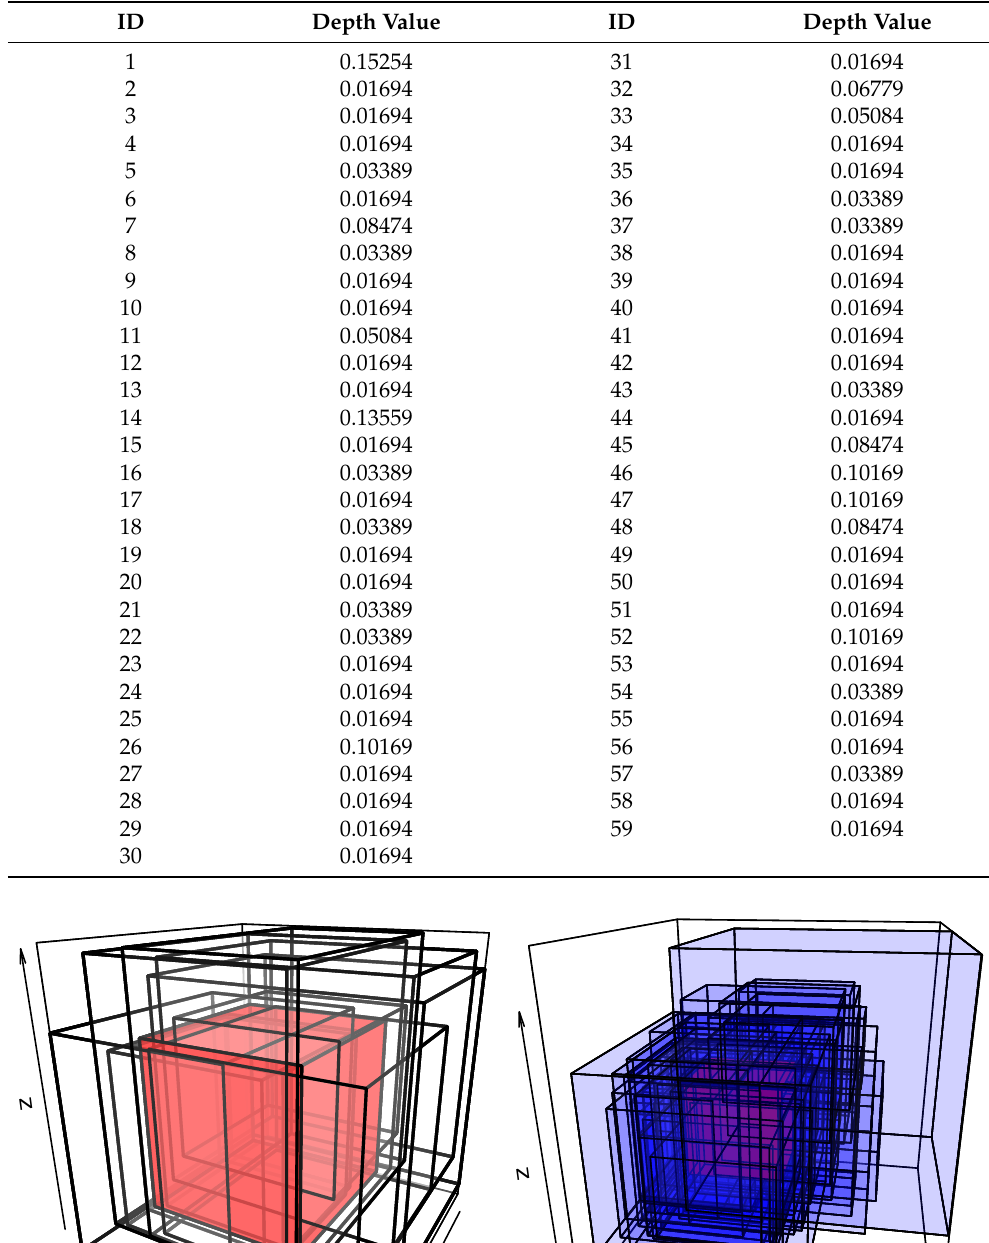
Table 2. Tukey depth value of each element in the cardiology three-dimensional cuboid dataset.